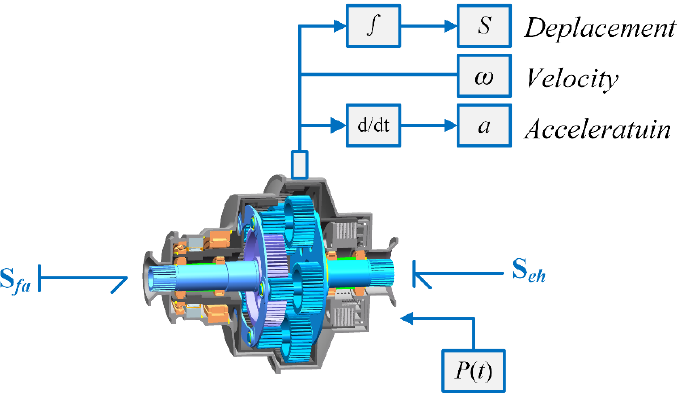
Figure 10. Dynamic design scheme of the transmission system based on the BG model.